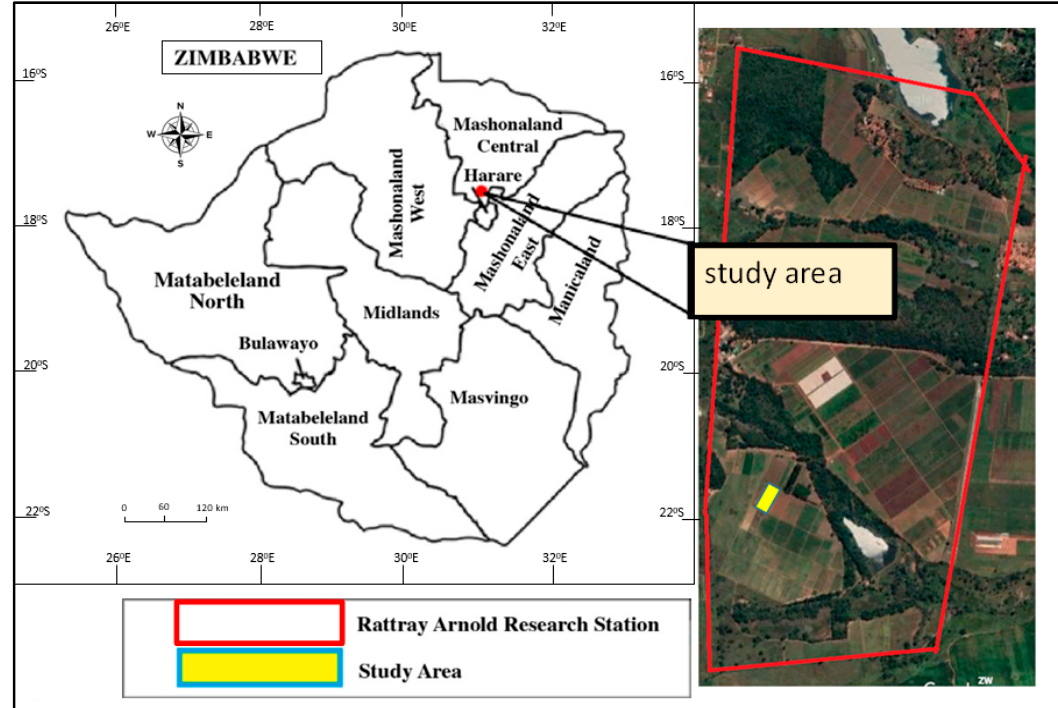
Figure 1. The location of the study area at Rattray Arnold Research Station. The figure on the right is the aerial image of Rattray Arnold Research Station (Source: Google Earth images).